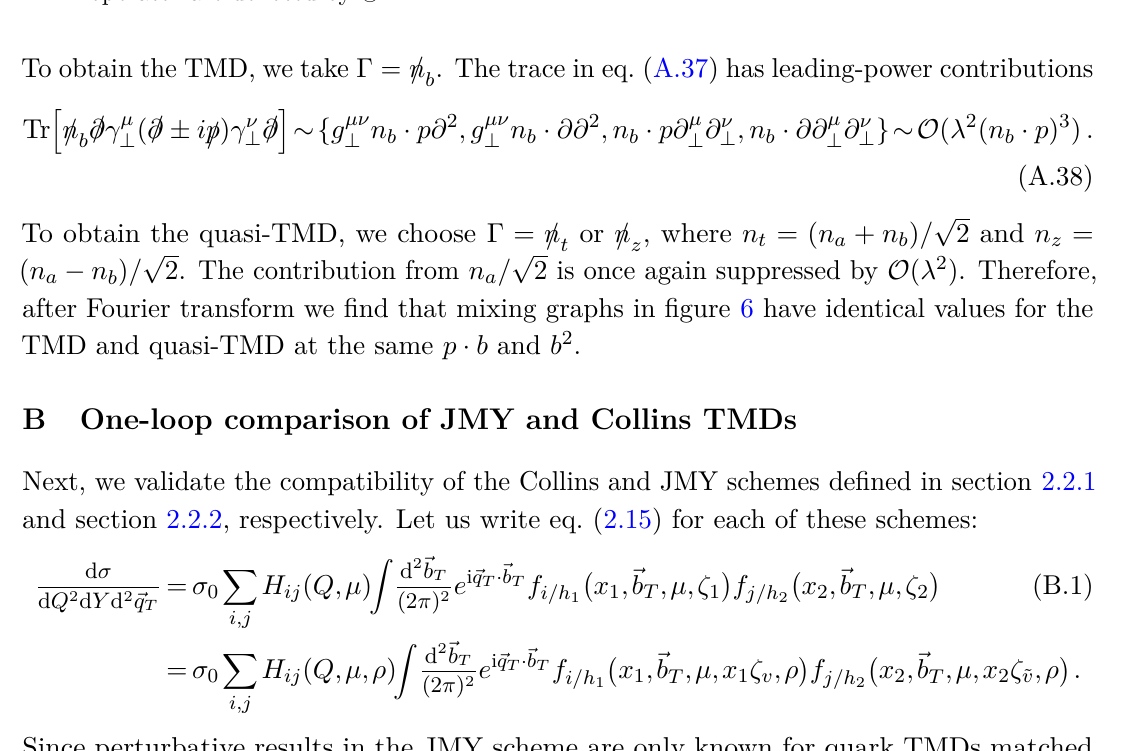
Figure 6 . Mixing of gluon TMDs into quark TMDs at lowest order, O ( α s ) . The quark fields of the TMD operator are denoted by ⊗